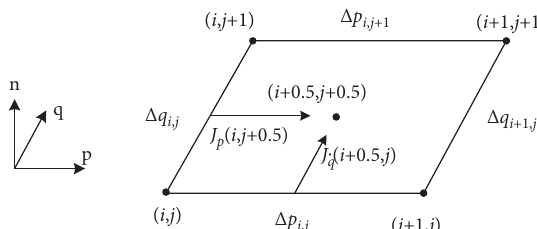
p and J q denote the directions of